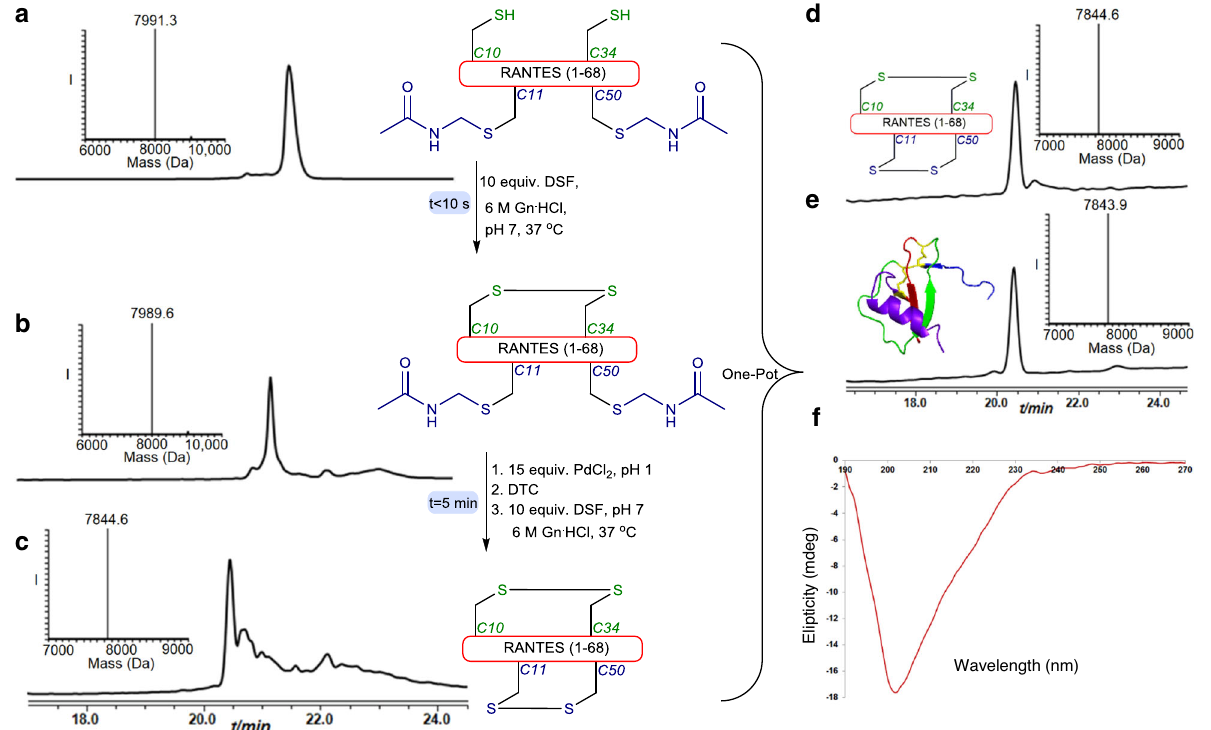
Fig. 3 RANTES synthesis. a HPLC-ESI MS analyses: Reaction at time zero, the main peak corresponds to reduced RANTES modi fi ed with two Acm groups and two free Cys with the observed mass 7991.3 ± 0.1 Da, calcd. 7992.0 Da (average isotopes). b Reaction after 1 min: the main peak corresponds to RANTES bearing one disul fi de bond and modi fi ed with two Acm with the observed mass 7989.6 ± 0.3 Da, calcd. 7990.0 Da (average isotopes). c Reaction after 5 min:HPLC-ESI MS, the main peak corresponds to RANTES bearing two disul fi de bonds with the observed mass 7844.6 ± 0.1 Da, calcd. 7846.0Da (average isotopes). d Puri fi cation and folding: the main peak corresponds to RANTES bearing two disul fi de bonds with the observed mass 7844.7 ± 0.1 Da, calcd. 7846.0 Da (average isotopes). e commercially available native RANTES: analyses with the observed mass 7843.9 ± 0.1 Da, calcd. 7846.0Da (average isotopes). f CD spectrum of the synthetic